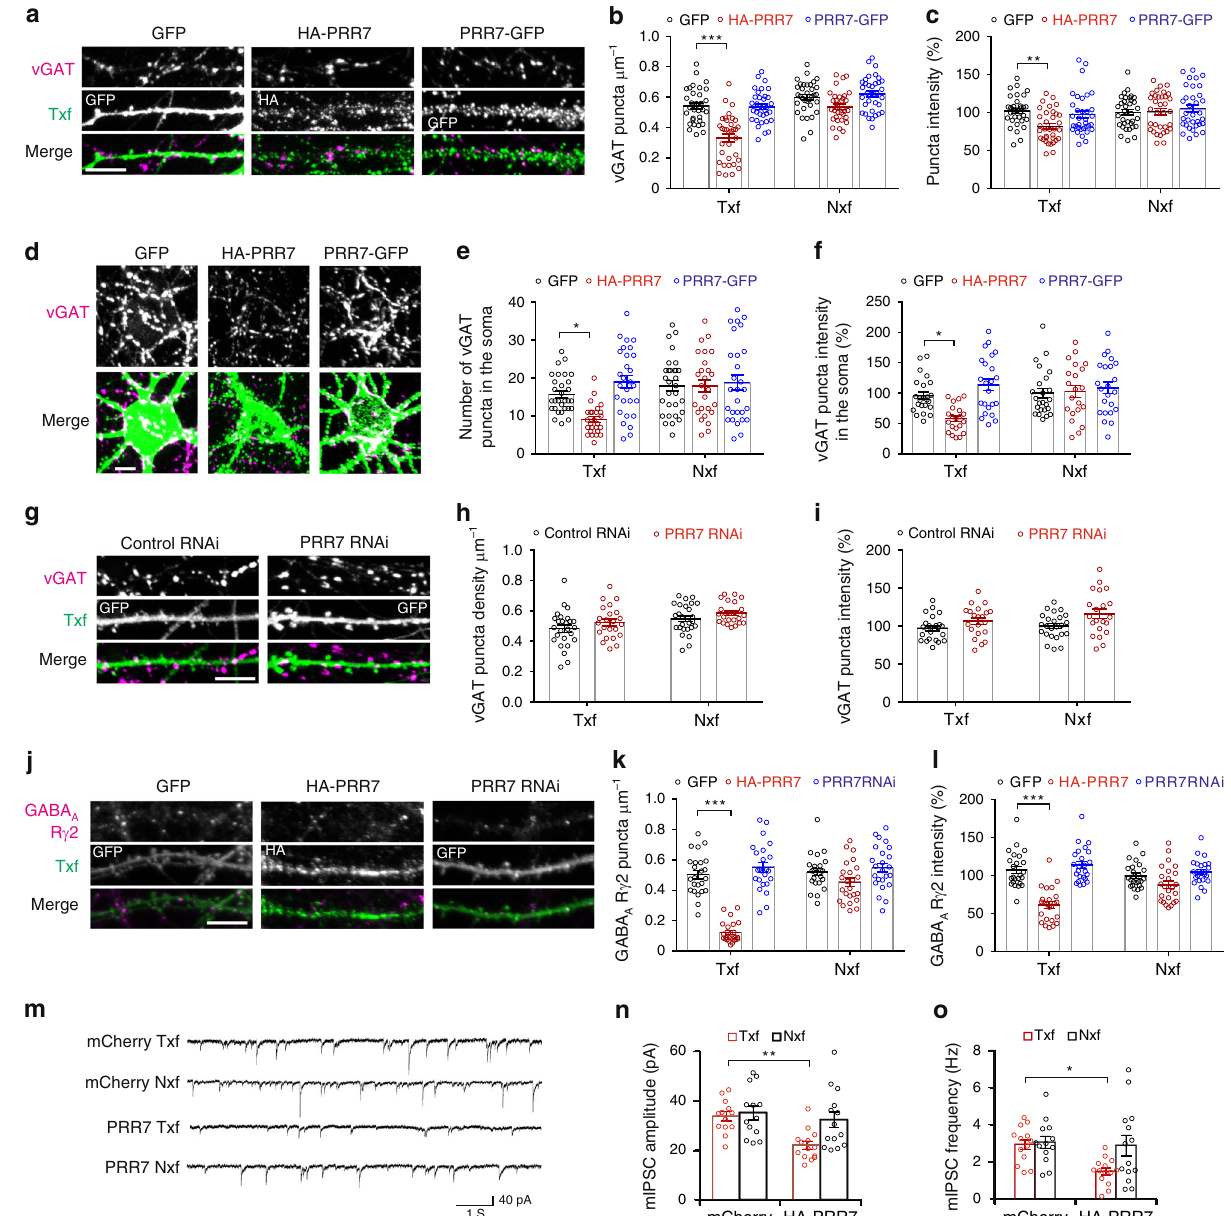
Fig. 4 Effect of PRR7 on GABAergic synapses. a Representative immuno fl uorescent images of vGAT in the dendrites of hippocampal neurons transfected with GFP, HA-PRR7, or PRR7-GFP. b , c Quantitation of vGAT puncta densities ( b ) and intensities ( c ) in hippocampal neurons transfected with GFP, HA- PRR7, or PRR7-GFP. n = 34 each. d Representative immuno fl uorescent images of vGAT in the soma of hippocampal neurons transfected with GFP, HA- PRR7, or PRR7-GFP. e , f Quantitation of vGAT puncta densities ( e ) and intensities ( f ) in the soma of hippocampal neurons transfected with GFP, HA-PRR7, or PRR7-GFP. n = 26 – 30. g Representative immuno fl uorescent images of vGAT in the dendrite of hippocampal neurons transfected with Control RNAi or PRR7 RNAi. h , i Quantitation of vGAT puncta densities ( h ) and intensities ( i ) in hippocampal neurons transfected with control RNAi or PRR7 RNAi. n = 21 – 24. j Representative immuno fl uorescent images of GABA A R γ 2 in the dendrite of hippocampal neurons transfected with control RNAi or PRR7 RNAi. k , l Quantitation of GABA A R γ 2 puncta densities ( k ) and intensities ( l ) in hippocampal neurons transfected with control RNAi or PRR7 RNAi. n = 24 each. m – o Effect of PRR7 overexpression on mIPSCs of hippocampal neurons. Representative mIPSC traces ( m ) and quanti fi cations of mIPSC amplitude ( n ) and frequency ( o ). n = 13 – 14. Scale bars, 5 μ m. Two-way ANOVA with post hoc Tukey ’ s test: F 2,198 = 32.59 ( c ), F 2,198 = 3.963 ( d ), F 2,162 = 6.695 ( e ), F 2,130 = 6.999 ( f ), F 2,198 = 59.26 ( k ), F 2,138 = 37.33 ( l ), F 1,50 = 8.925 ( n ), F 1,50 = 5.01 ( o ). *** P < 0.0001, ** P = 0.0053 ( c ), * P = 0.025 ( e ), * P = 0.0163 ( f ), ** P = 0.0072 ( n ), and * P = 0.0328 ( o ). Data are mean ±